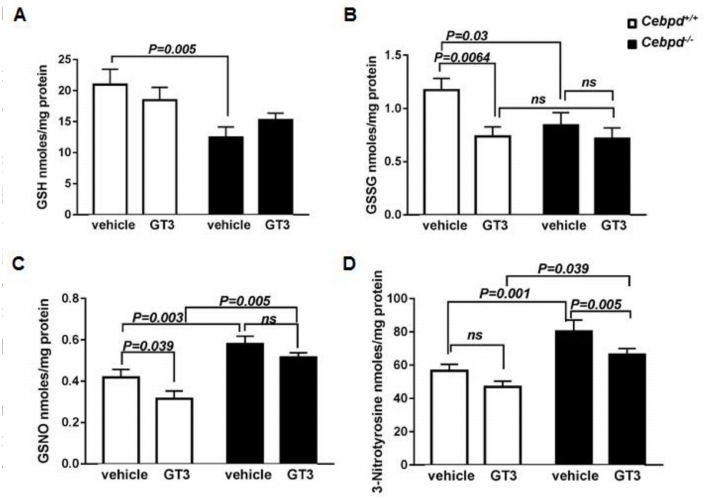
Figure 4. GT3 treatment promotes increased IR-induced oxidative and nitrosative stress in Cebpd − / − mice compared to Cebpd + / + mice. The intestinal levels of ( A ) GSH; ( B ) GSSG, ( C ) GSNO and ( D ) 3-NT were measured in intestine tissues of vehicle- or GT3- treated Cebpd +/+ and Cebpd − / − mice at day 3.5 post-exposure to 8.5 Gy ( n = 7–8 mice/genotype/group). All the data are presented as mean + S.E.M. of n = 3–8 mice per treatment per genotype. p < 0.05 was considered statistically significant.